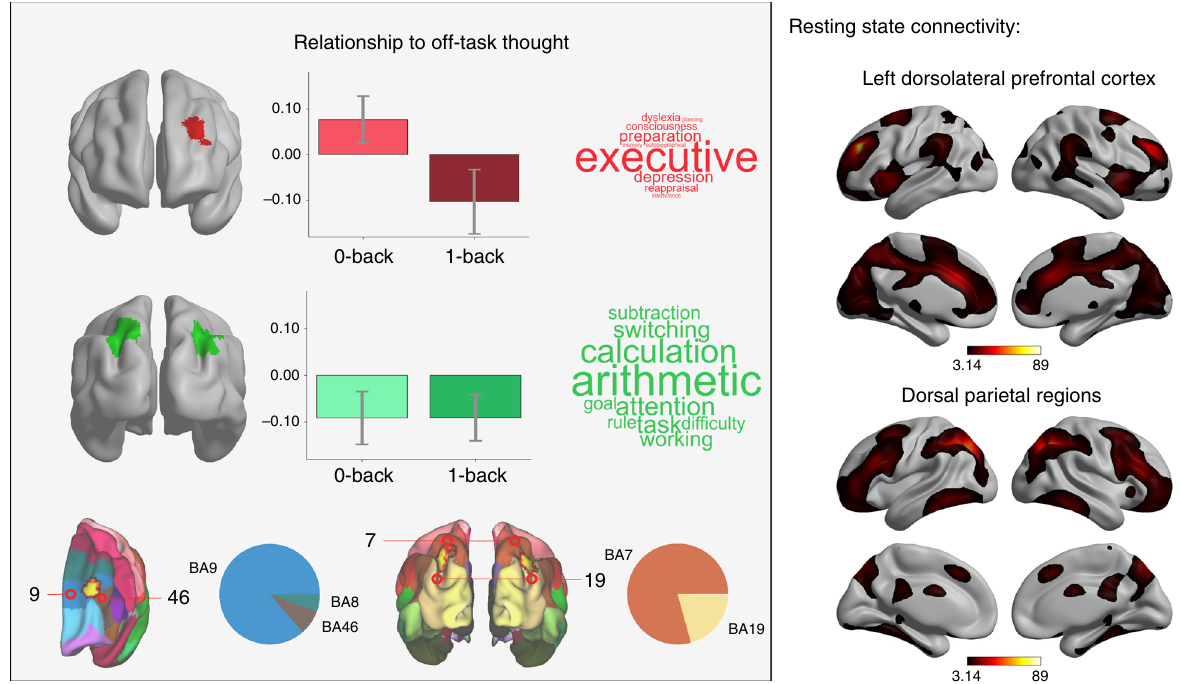
Fig. 2 Establishing regions supporting on-task experience and those involved in the regulation of ongoing thought in line with the demands of the external environment. A region of dorsolateral prefrontal cortex (BA8, 9, and 46) was related to off-task thought during the 0-back and on-task thought during the 1-back (top and bottom left). Bilateral parietal regions (BA7 and 19) were related to on-task thought irrespective of task demands (middle left, centre bottom). The pie charts indicate the overlap of the regions identi fi ed by our analysis with Brodmann areas to enable a clearer understanding of their anatomical location. These regions show different patterns of resting-state functional connectivity (right). Wordclouds represent associations from meta- analytic decoding 25 . Statistical thresholds are identical to those in Fig.